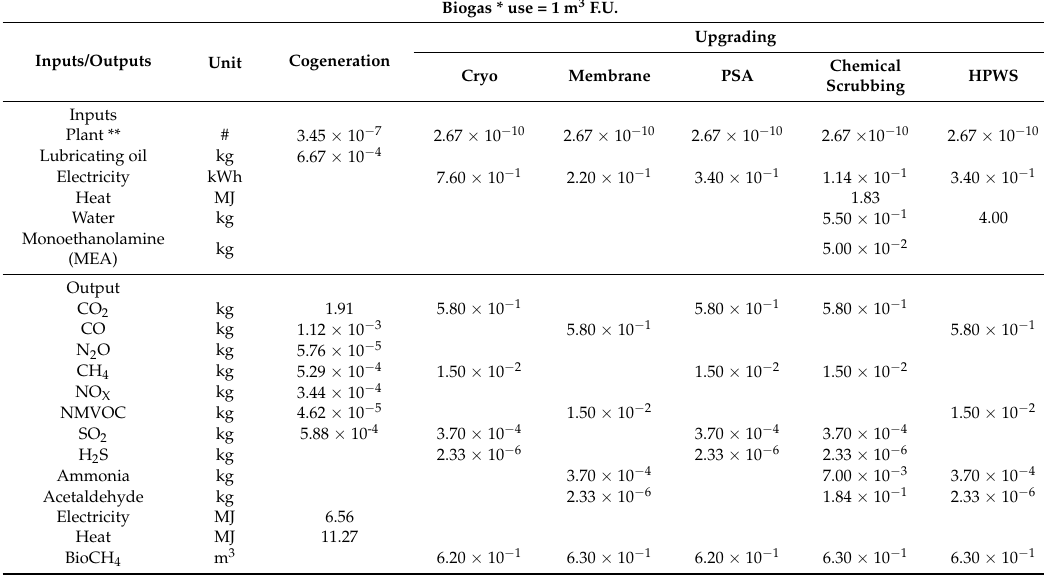
Table 1. Life Cycle Inventory. Values are referred to the functional unit of 1 m 3 of used biogas. Biogas * use = 1 m 3